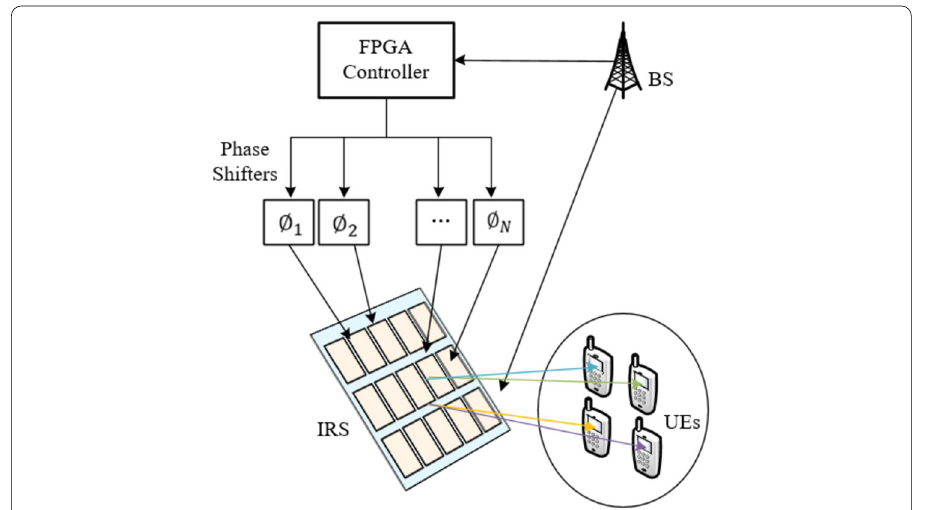
Fig. 4 Phase-shift-controlled IRS-assisted communication. Learning from the implementation of PAA technology, IRS can also reconstruct the reflection characteristics of the IRS surface by changing the phase of the artificial unit in real time, thereby generating beams with different directions and different numbers of beams to support simultaneous multi-user